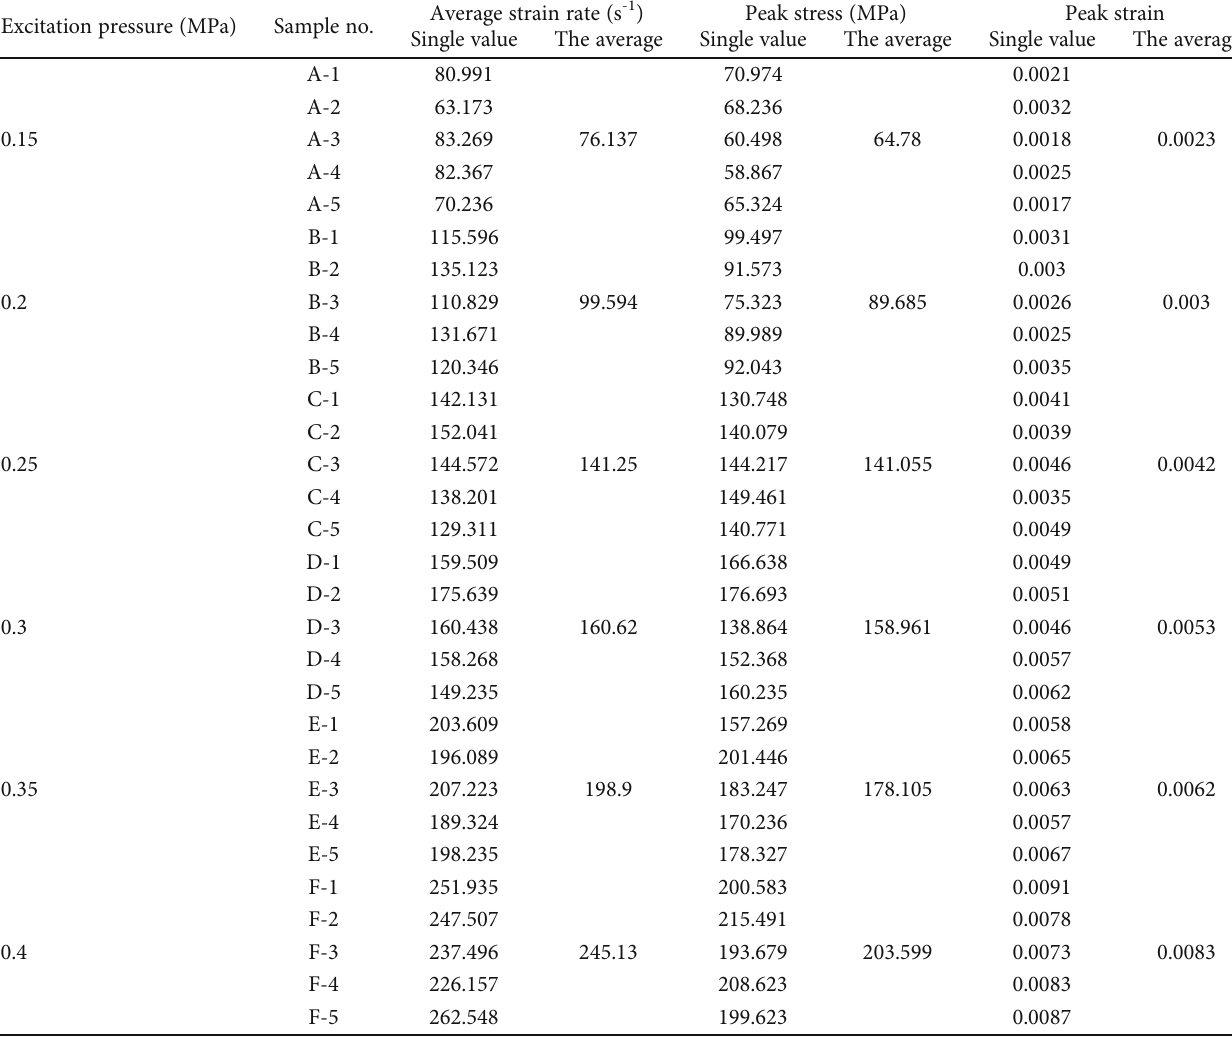
Table 3: Results of uniaxial impact compression tests of granites.